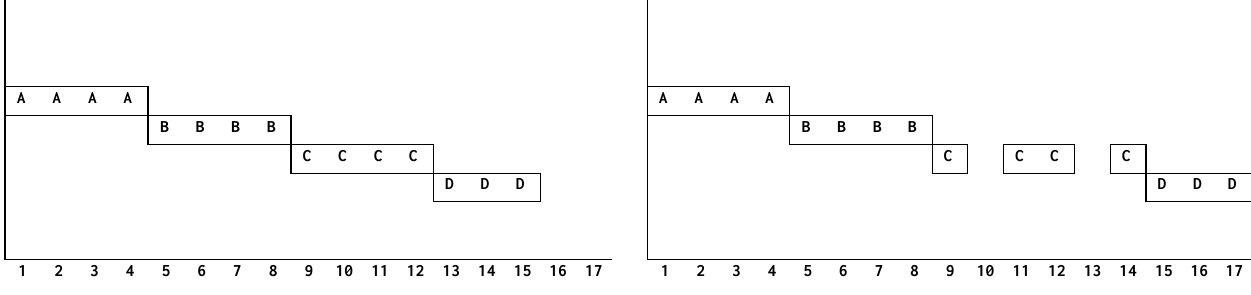
Fig. 1. Comparing Different Styles of Calculating ES with and without Activity Splitting (Left to